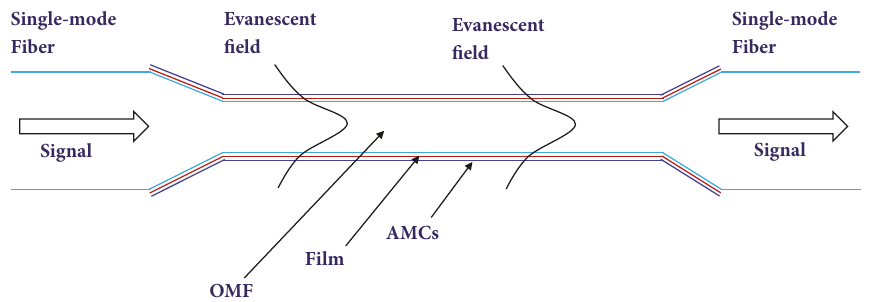
Figure 1: Principle of molecular contaminants adhered on microfibre with HSNs